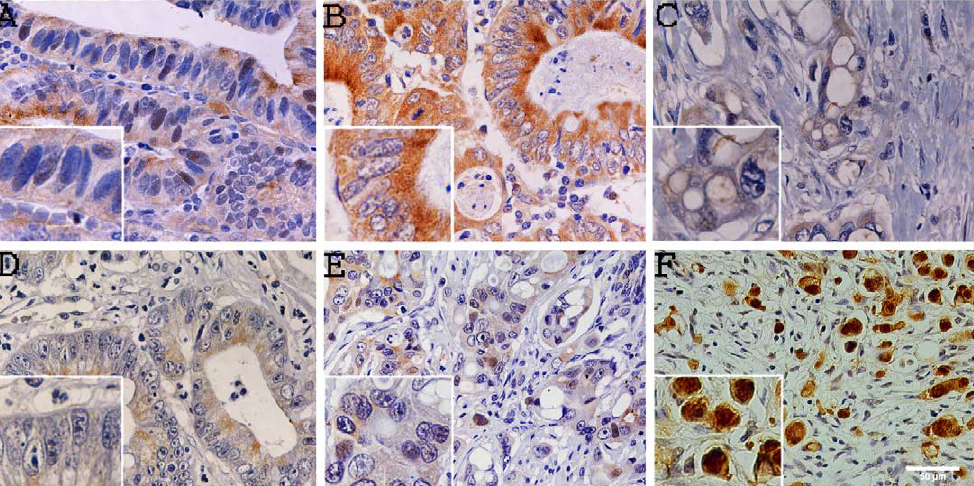
Fig. 2. Subcellular SnoN localization differentially correlates to tumor stage and grade. (A–C) Cytoplasmic SnoN expression correlates with disease stage. Higher cytoplasmic expression of SnoN in a stage II tumor (B) compared to tumors of stage 0 (A) or III (C). (D–F) Nuclear SnoN correlates with tumor grade. Negative nuclear SnoN staining in a grade I tumor (D). Weak SnoN nuclear expression in a grade II carcinoma (E). A grade III tumor showing strong nuclear immunoreactivity for SnoN (F) (400 × magnification). Inserts in lower left corner show the subcellular localization of immunostaining in each case at higher magnification (2 × original objects). Bar corresponds to 50 µm.